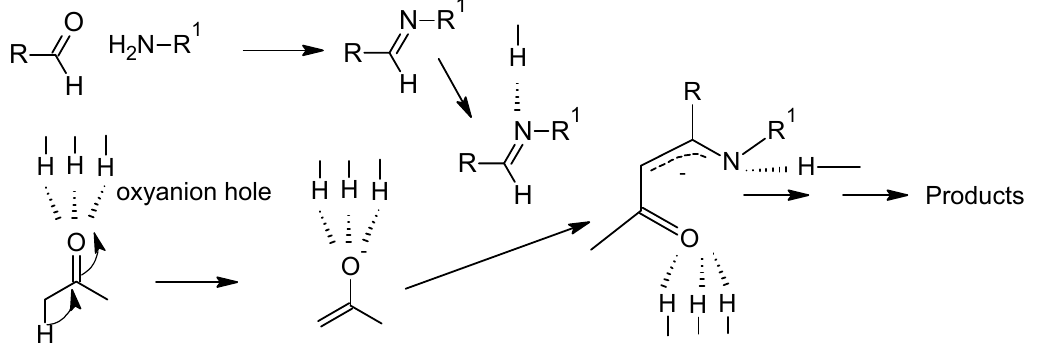
Scheme 14. Mechanism of the Lipase-catalysed Mannich reaction. Scheme 14. Lipase-catalyzed Mannich reaction. Scheme 14. Lipase-catalyzed Mannich reaction.